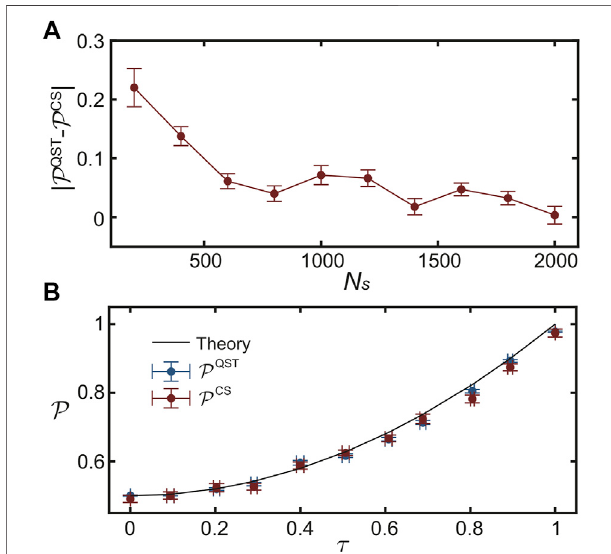
FIGURE 2 | (A) Average estimated P CS of 11 prepared states with different N s . (B) The results of P CS (blue dots) and P QST (red dots). The black line is the theoretical prediction of purity of ideal ρ ( τ ).